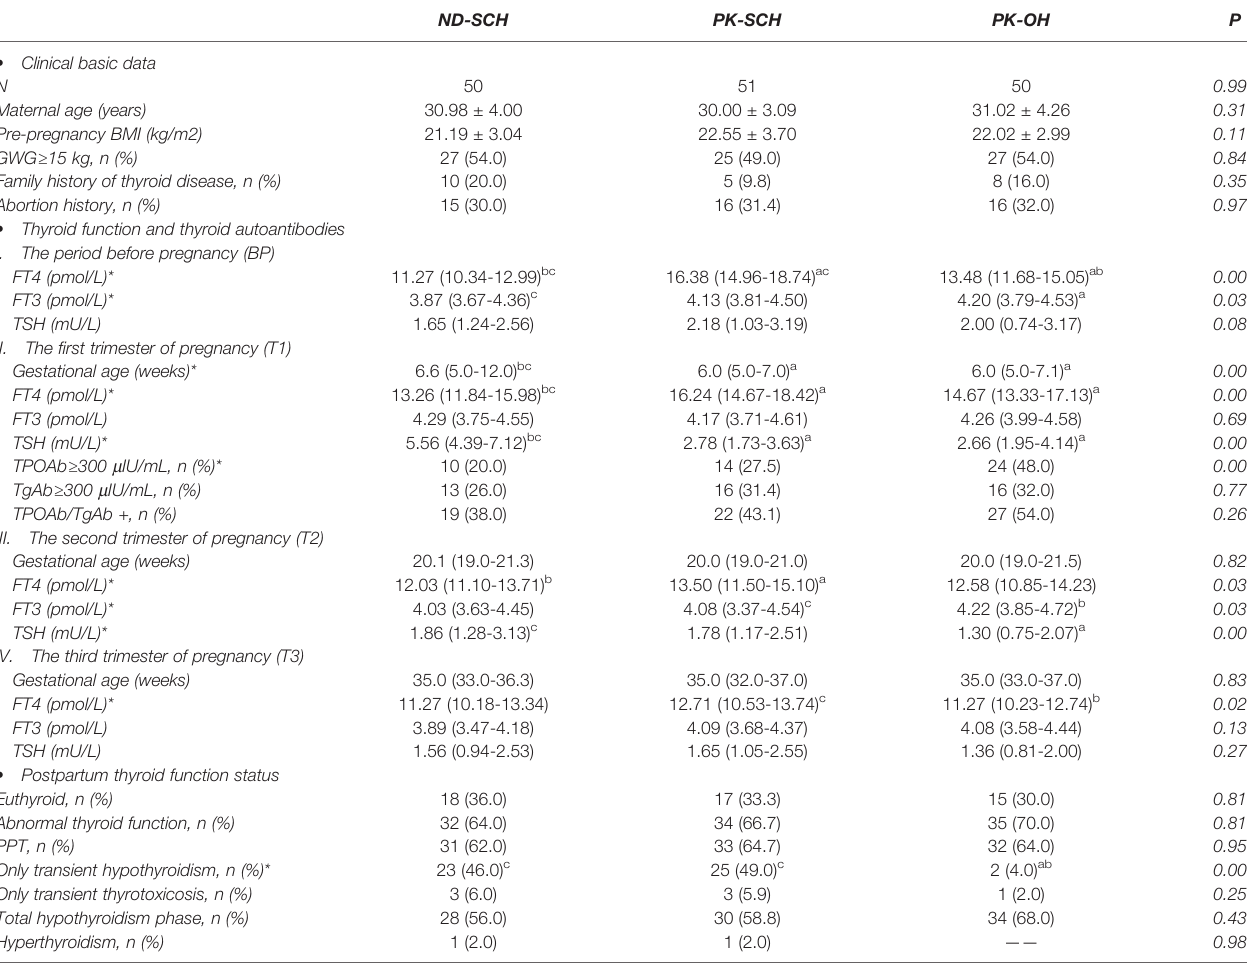
TABLE 1 | Descriptive statistics of women grouped according to thyroid function (n = 151). ND-SCH PK-SCH